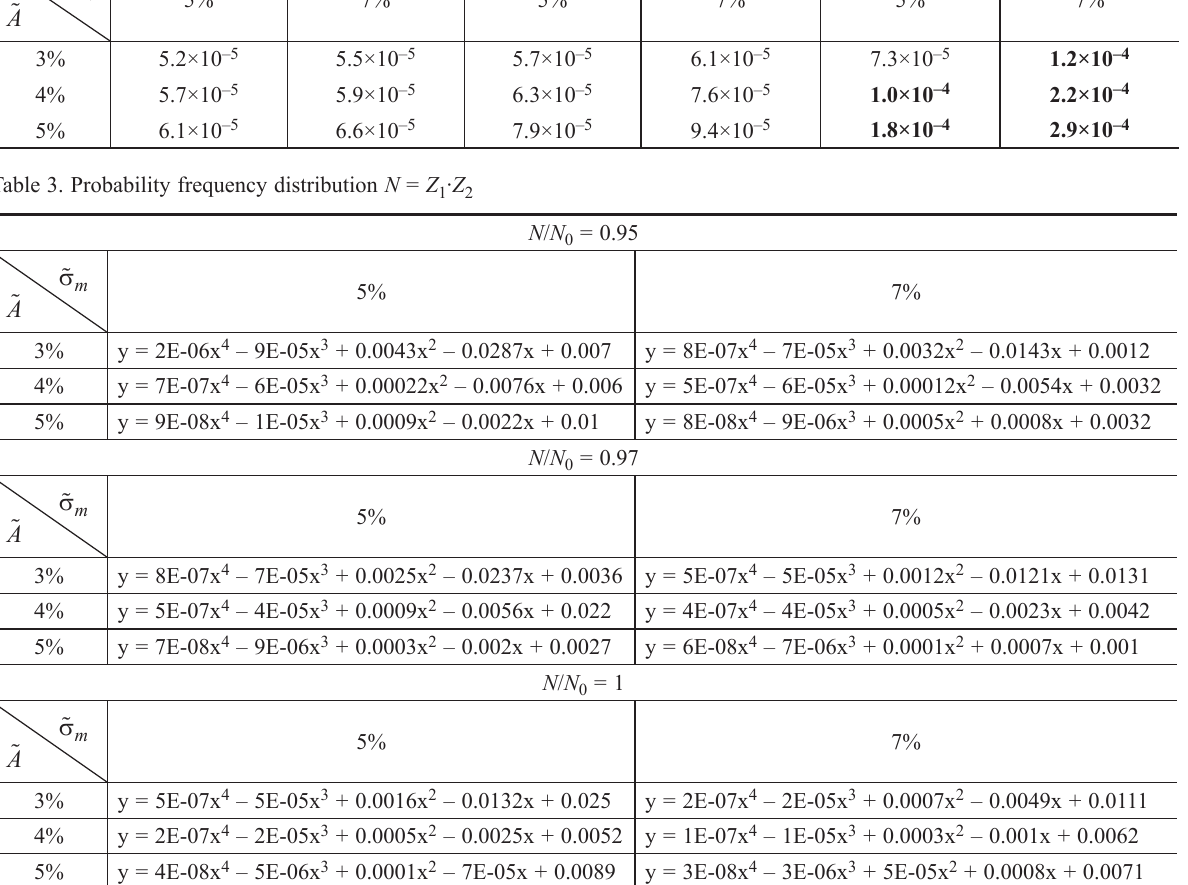
Table 2. Lower limit of reliability (failure probability of P f member)